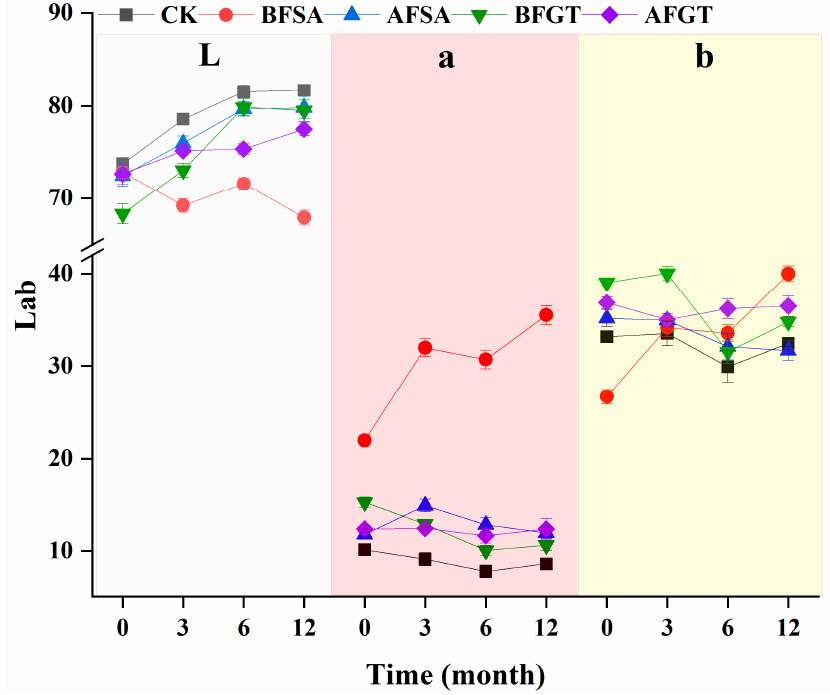
Figure 4. Effects of added sinapic acid and grape tannin on the color parameters brightness (L*), redness (a*) and yellowness (b*) of cherry wine. Table 2. Anthocyanins and anthocyanin-derived compounds identified in the cherry wines by UPLC-MS. Peak No.